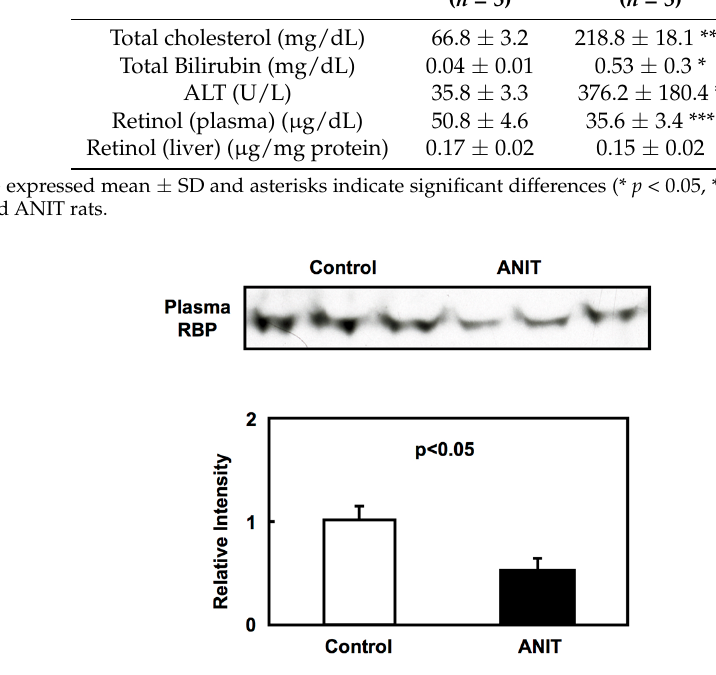
Figure 1. Plasma retinol binding protein (RBP) immunoblotting. Plasma samples from control rats and α -naphthylisothiocyanate (ANIT) rats ( n = 3 for each group) were analyzed by immunoblotting to detect plasma RBP levels as described in Material and Methods. Each bar represents the mean value ± SD and significant differences are indicated in the graph. Table 1. Biochemical profiles and retinol status between control and ANIT rats.